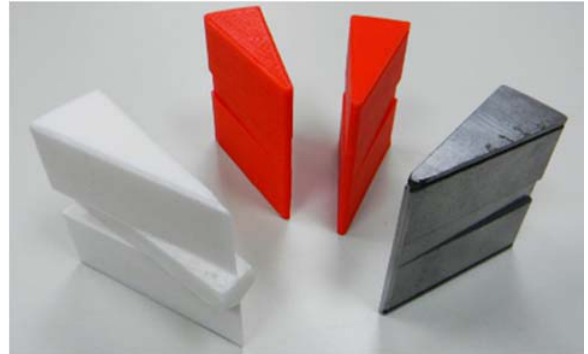
Figure 12. Evolution of stator pole pieces.